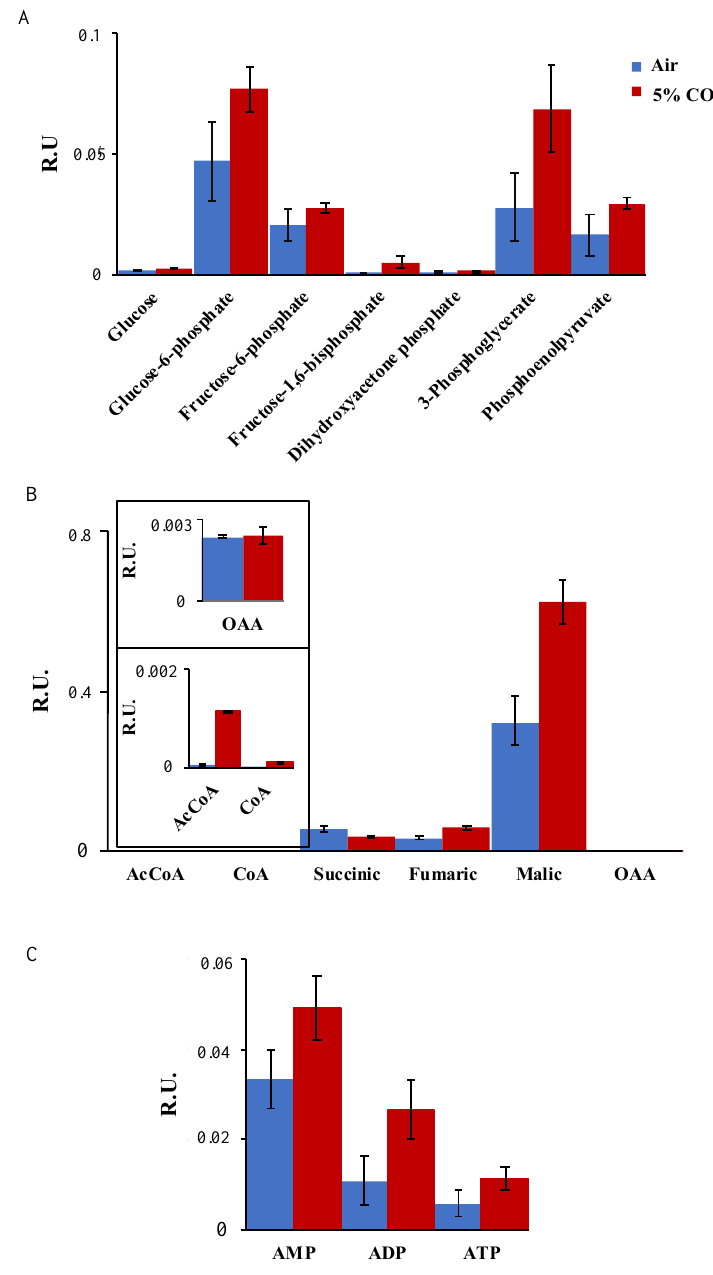
Figure 4. Metabolites presented in C. sorokiniana under different CO 2 concentrations: UPLC–MS analysis of ( A ) glycolysis–related metabolites, ( B ) TCA related metabolites and ( C ) phosphorylated nucleotides in C. sorokiniana samples subjected to air or 5% CO 2 . The mean ± SE was calculated and performed in quintuplicate for each condition, and two biological replicates were analyzed as described in the Methods